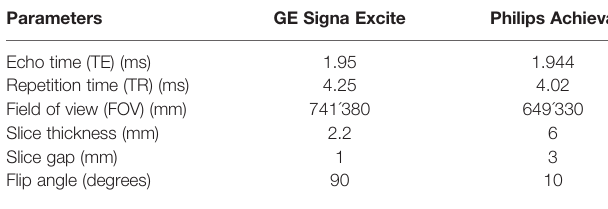
TABLE 1 | Parameters of two MRI